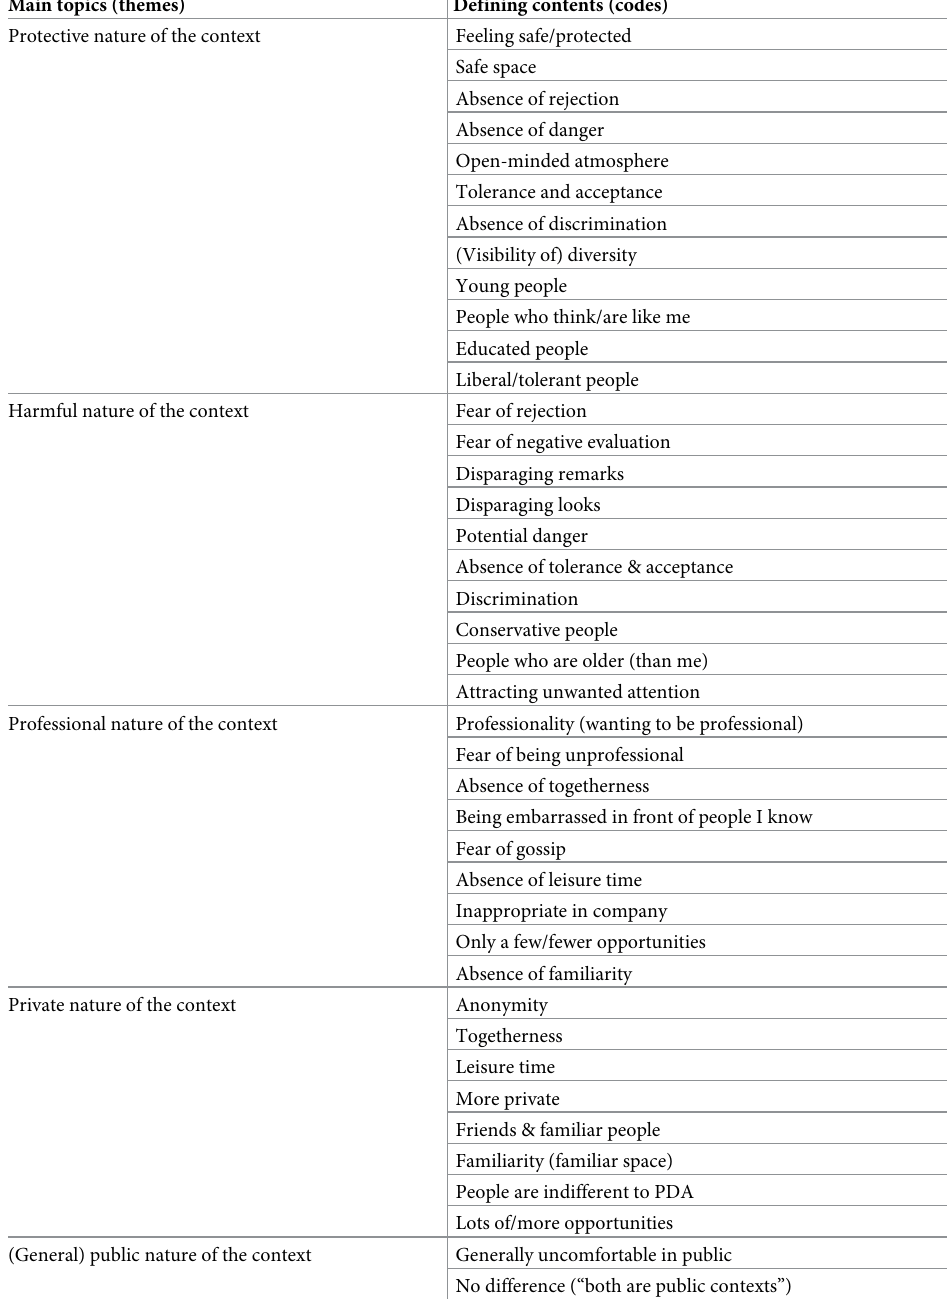
Table 5. Themes on negotiating PDA in different public